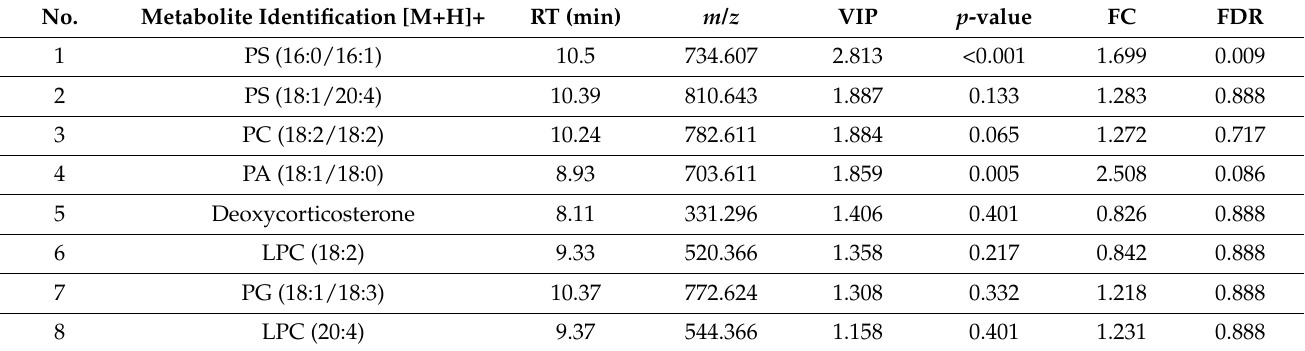
Table 2. Metabolites with VIP > 0.8 on all components in group C vs. 0 (MDD1), p - and FC